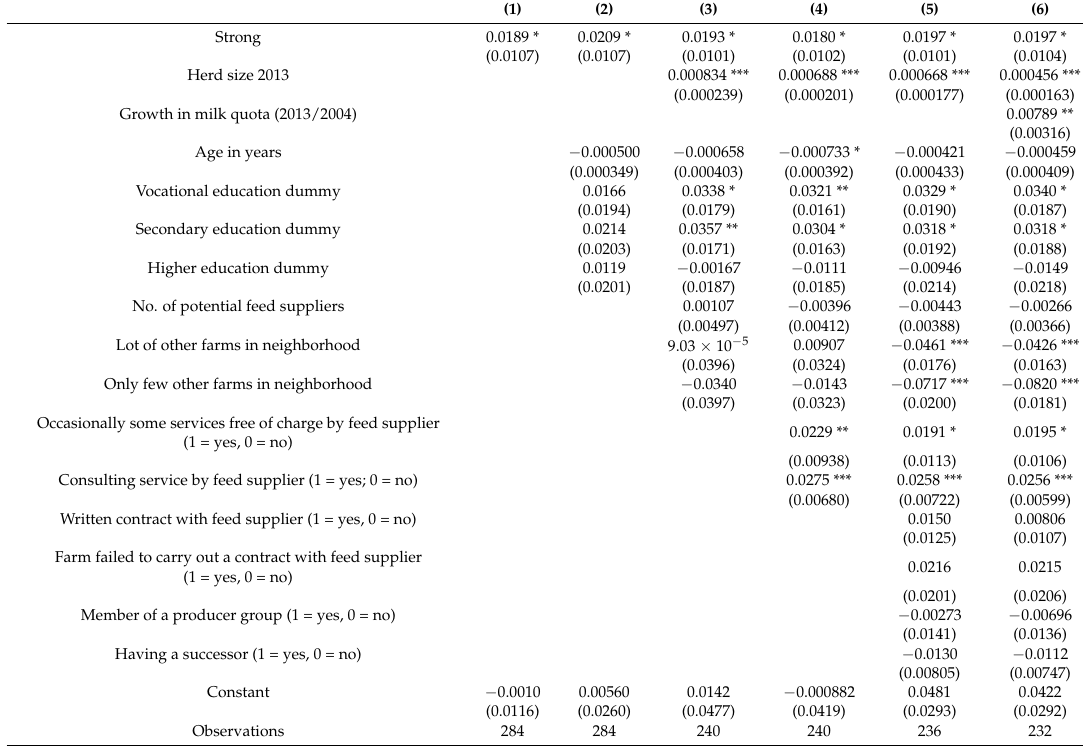
Table 2. Farmers’ subjective bargaining power and discount obtained when buying